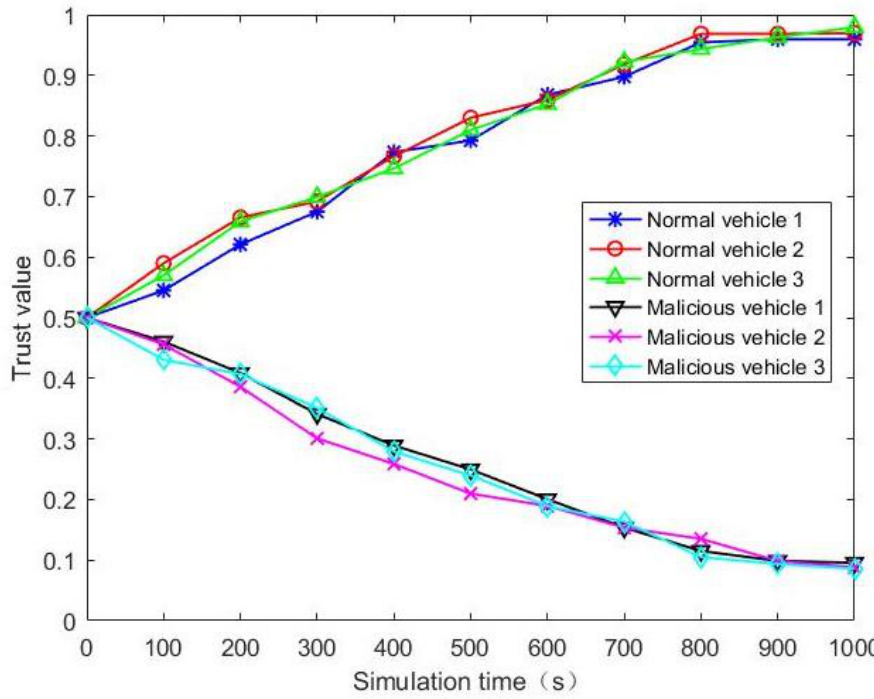
Figure 8. Vehicle simulation experiment trust value results.